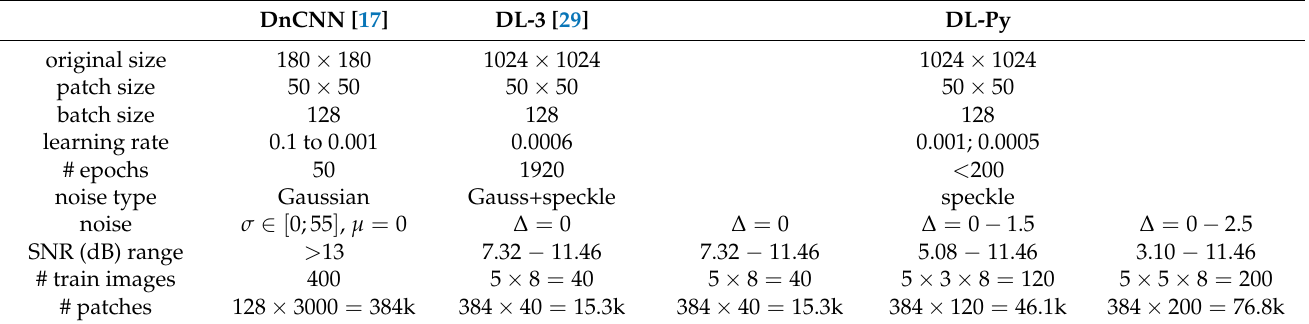
Table 2. Parameters used to train the networks. ∆ lies for the simulated speckle